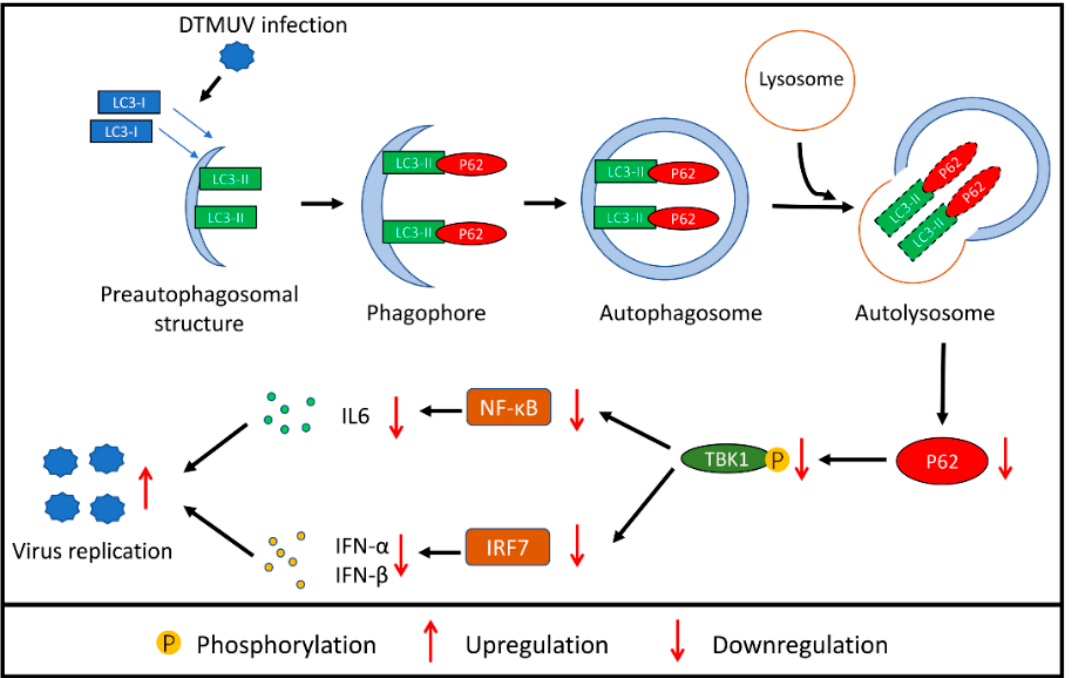
Figure 8. Proposed model of autophagy promotes DTMUV replication by suppressing p62/SQSTM1-mediated innate immune responses in DEF cells.